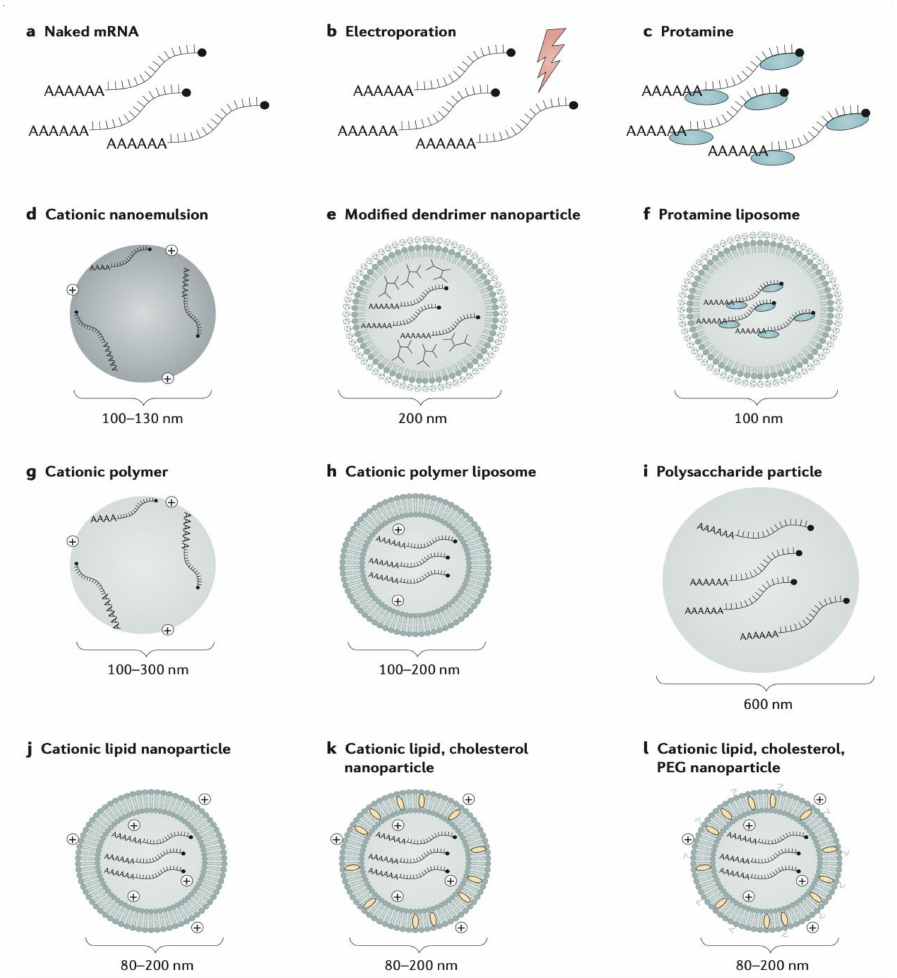
Figure 4. mRNA vaccine delivery vehicles. Reproduced with permission from Pardi, N. et al., Nat Rev Drug Discov; published by Springer Nature, 2018